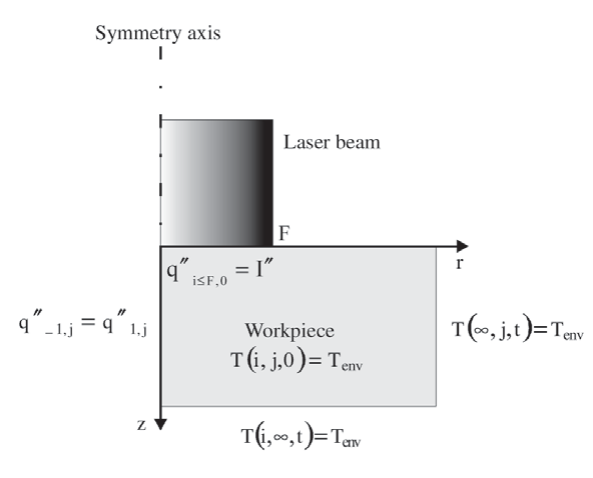
Figure 1 . Schematic representation of the boundary conditions.